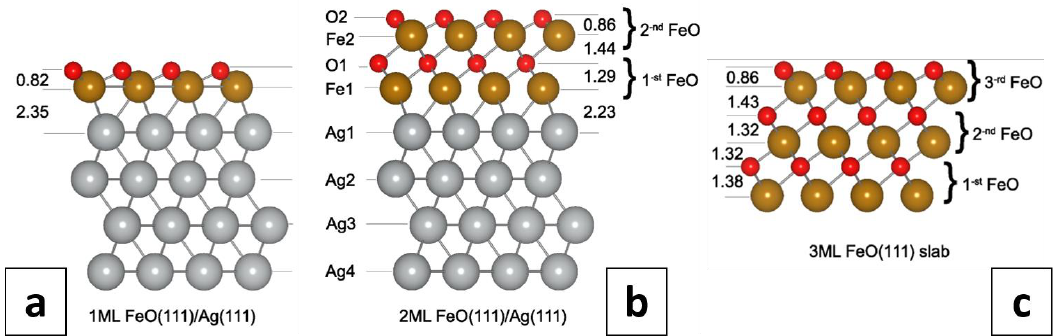
Figure 6. Side views of calculated O-terminated monolayer ( a ) and bilayer ( b ) reconstruction-free FeO(111) films on Ag(111), as well as 3-MLs-thick FeO slab ( c ), determined from PBE+U calculations using a 1 × 1 surface unit cell with fixed 2.938 Å FeO(111) and Ag(111) in-plane lattice constants (FeO(111) film adopting the geometry of the Ag(111) substrate). All distances are given in